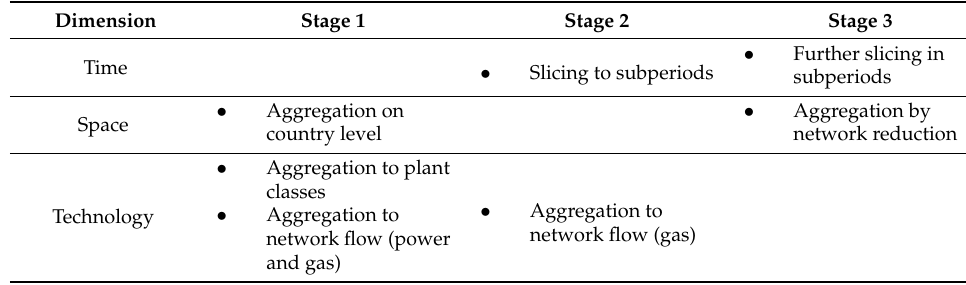
Table 3. Applied model reduction